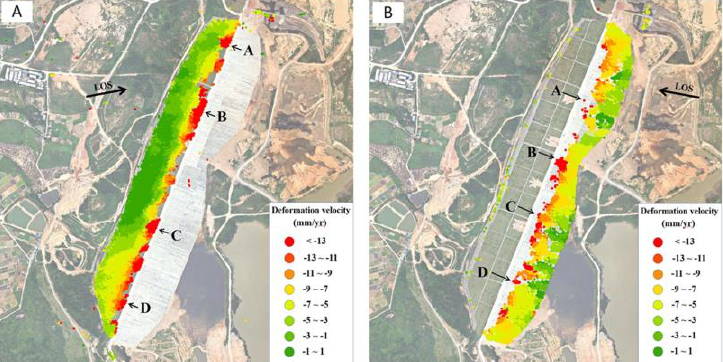
Figure 16. The average velocity results from the CSK-SM data sets by the stacking method: ( a ) the downstream slope in the ascending orbit and ( b ) the upstream slope in the descending orbit.